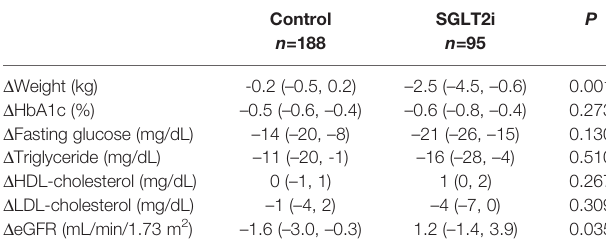
TABLE 2 | Comparison of 6-month changes in body weight, serum glucose, and TABLE 3 | Comparison of changes in transaminase levels and hepatic steatosis lipid pro fi les between the propensity score-matched control and SGLT2i groups. index between the propensity score-matched control and SGLT2i groups. Control